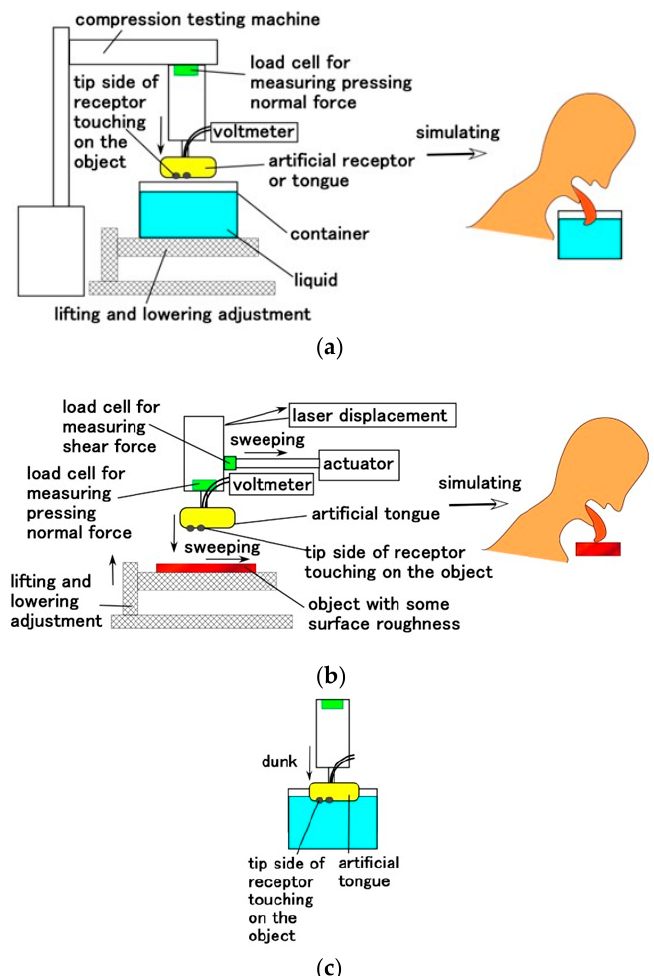
Figure 7. Schematic diagram of the experimental apparatus: ( a ) for the normal force experiment simulating dipping the tongue into a liquid for thermal and gustatory response and a rigid body for tactile response; ( b ) for the shear force experiment simulating licking a rigid body for tactile response; and ( c ) for the touching experiment of thermal and gustatory substances.